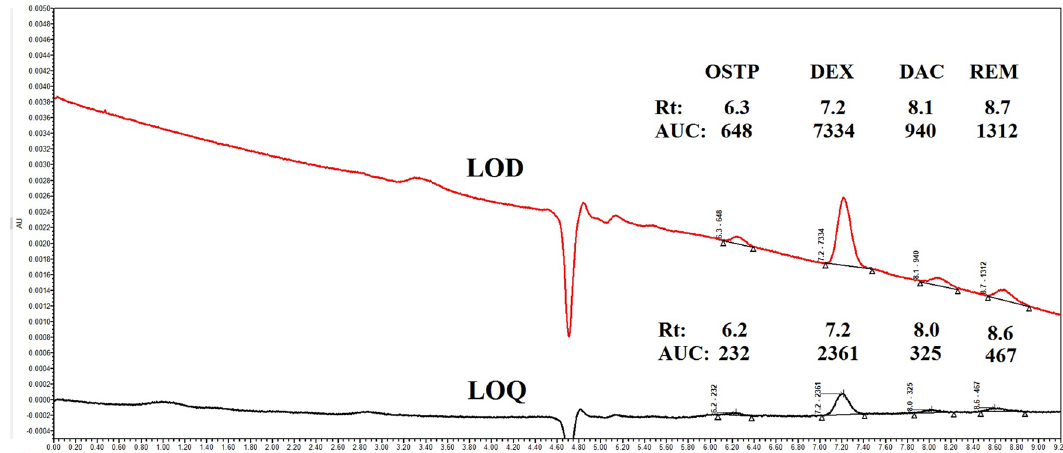
The LOD and LOQ values for the proposed method are shown in Table 2 and Fig. 2. The developed method has a sensitivity of 1.9 ng mL −1 for OSTP, 0.5 ng mL −1 for DEX, 2.0 ng mL −1 for DAC, and 0.5 ng mL −1 for REM, so the proposed method is suitable for their assay in human plasma. To achieve these low concentrations in plasma, solid-phase extraction (SPE), liquid–liquid extraction (LLE) with the salting-out technique, or liquid-phase microextraction (LPME) 58,59 are excellent choices. They clean up the sample and preconcentrate the target ana- lytes in very small volumes. This increases the concentration to a limit that can be detected by UV or PDA detec- tors. In addition, these techniques reduce the consumption of organic solvents, saving time, effort, and money.